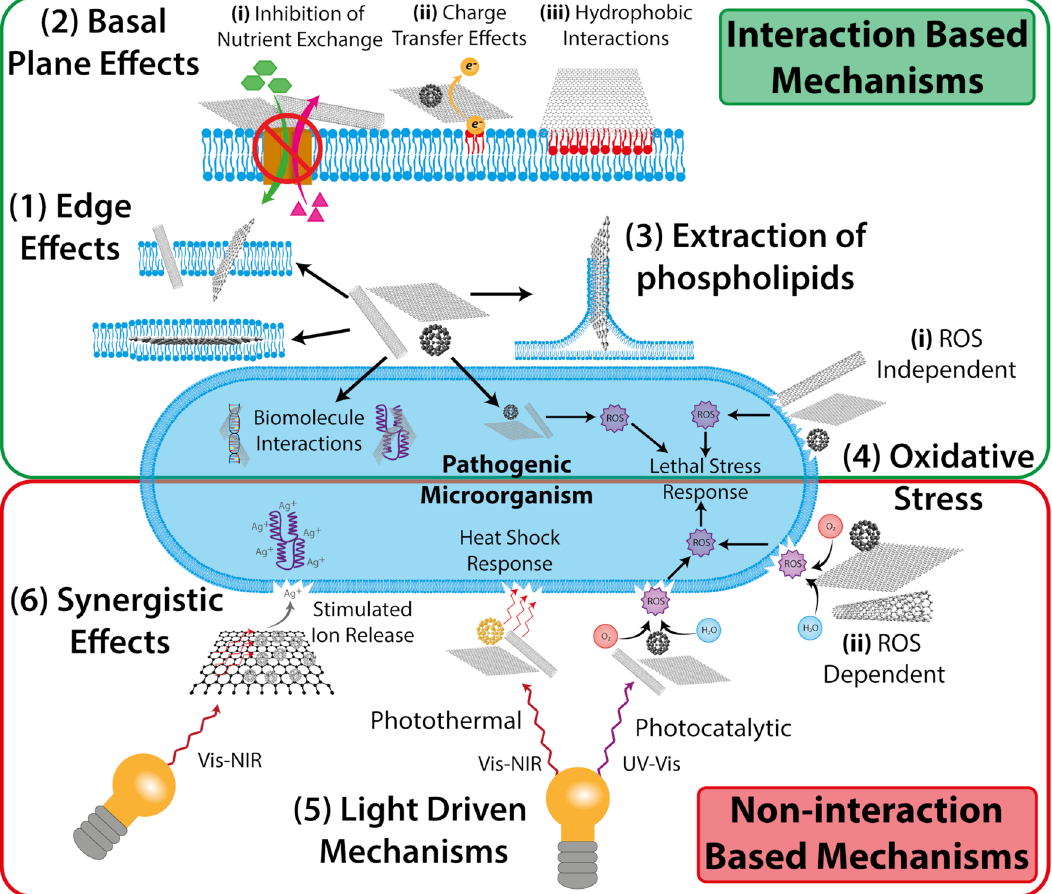
Fig. 3 Summary of the most accepted antimicrobial mechanisms of LDMs. A more detailed explanation of the mechanisms provided in antimicrobial mechanism